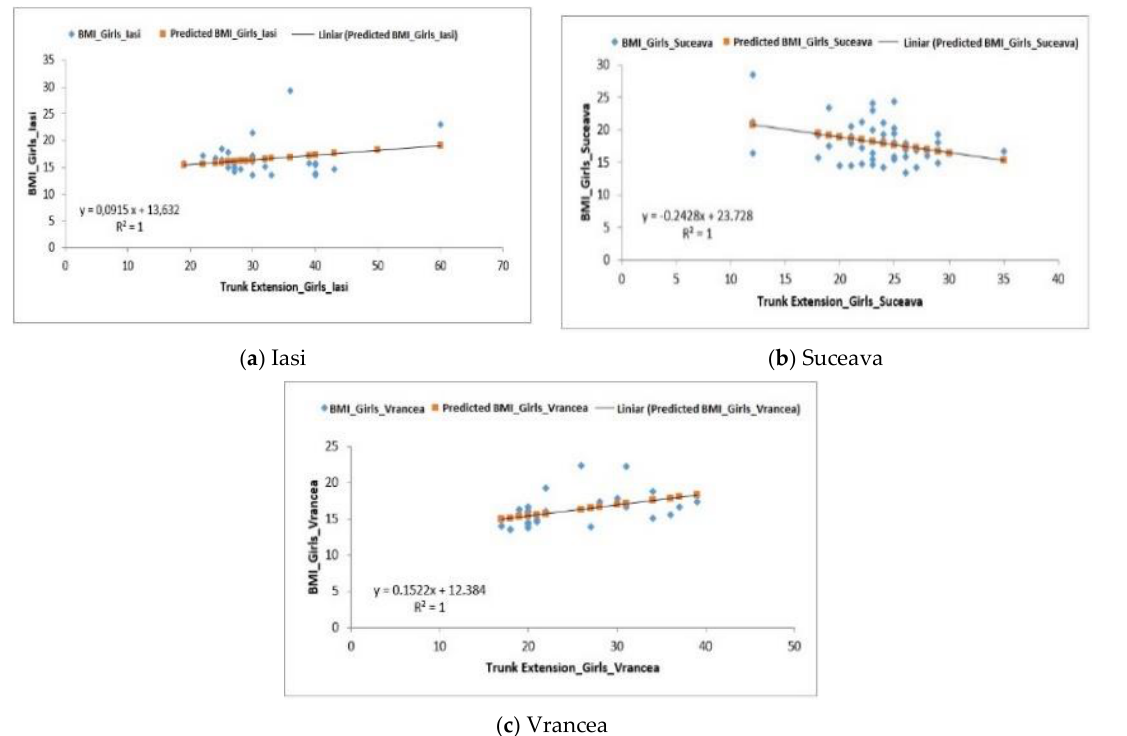
Figure 7. Relationship between the BMI and the upper body extension test for the boys in the three regions.